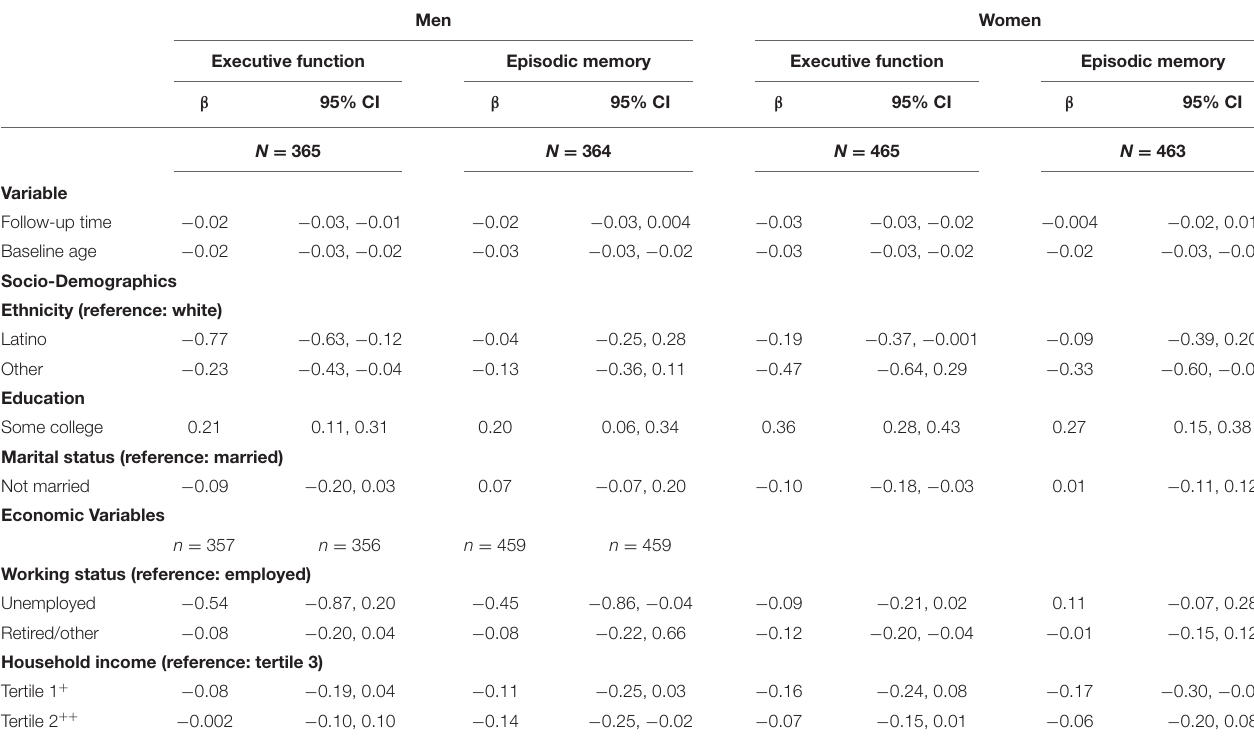
TABLE 3 | Effects of socio-demographic and -economic variables on executive function (EF) and episodic memory (EM) 10 years after baseline, adjusted for baseline age, time, socio-demographic and—economic